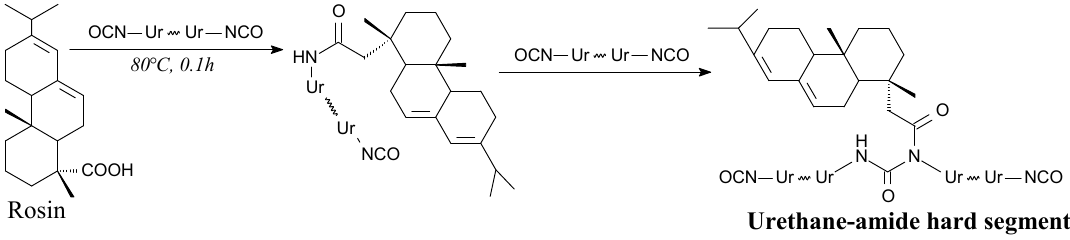
Scheme 64. Preparation of rosin-modified urethane-amide hard segments.